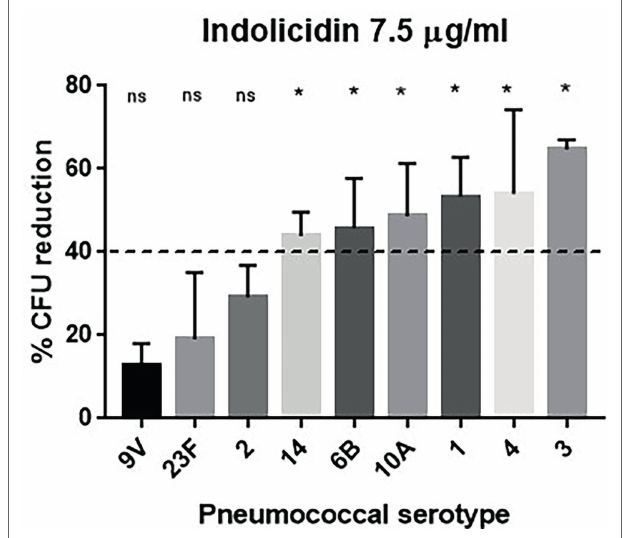
FIGURE 1 | Susceptibility of Streptococcus pneumoniae to indolicidin. Bacterial strains of different serotypes were treated with 7.5 μ g/ml indolicidin and plated. The percentage of bacterial reduction after treatment is shown for each strain. Statistical analysis was performed using ANOVA with a Dunnet post-test. * p < 0.05 in comparison with untreated control; ns, not significant.